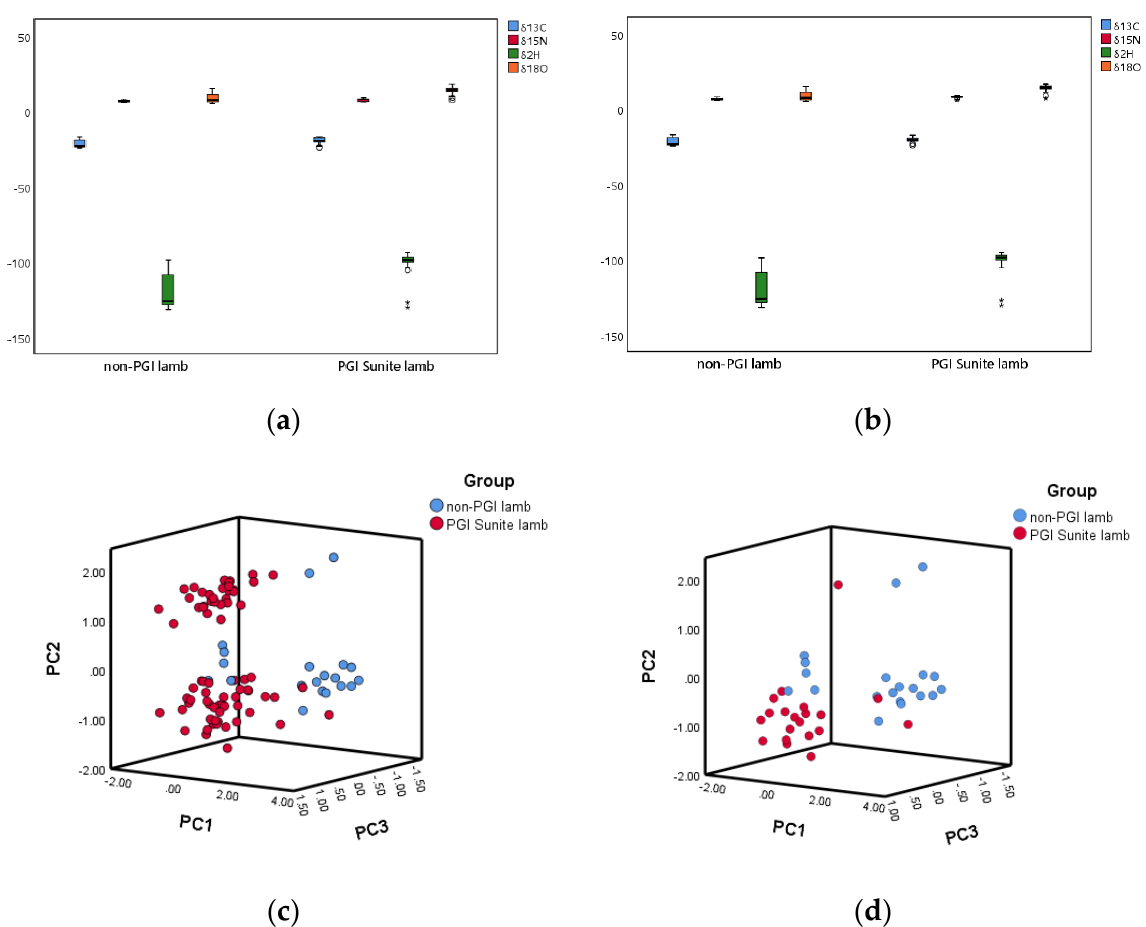
Figure 4. Boxplots of the δ 13 C, δ 15 N, δ 2 H, and δ 18 O values of ( a ) global lamb isotope library and ( b ) local lamb isotope library according to lamb groups; 3D–score plot of ( c ) global lamb isotope library and ( d ) local lamb isotope library according to lamb groups.